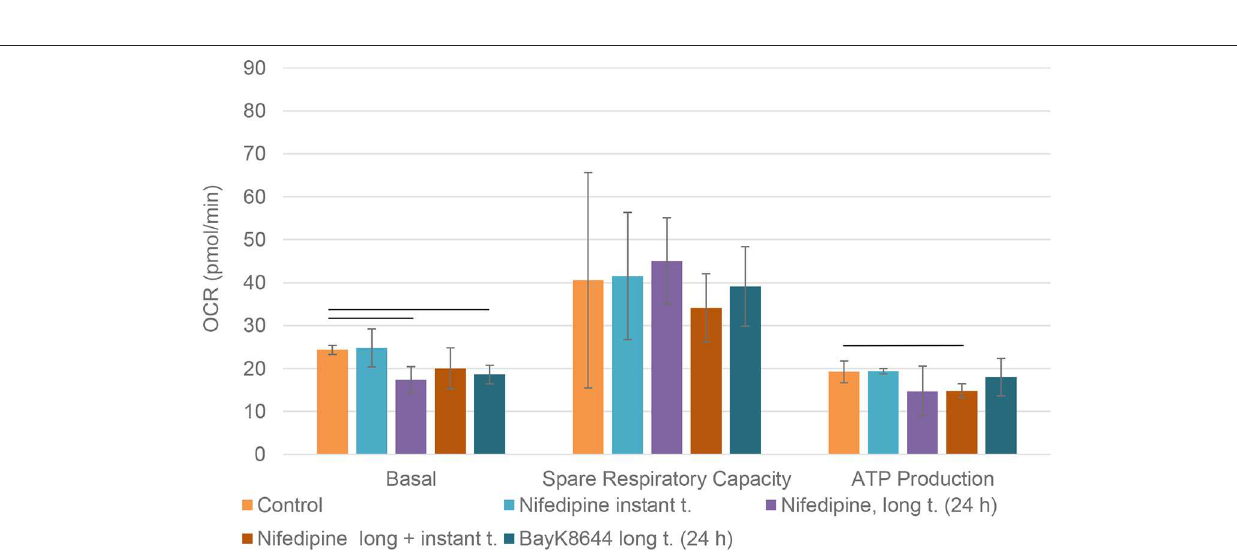
FIGURE 5 | Mitochondrial respiration in BMMSCs. The cells were treated with nifedipine (10 µ M) and BayK8644 (10 µ M) for 24h period (long t.), and additionally treated with nifedipine (10 µ M) during the measurement (instant t.). OCR, oxygen consumption rate. Horizontal bars represent p <